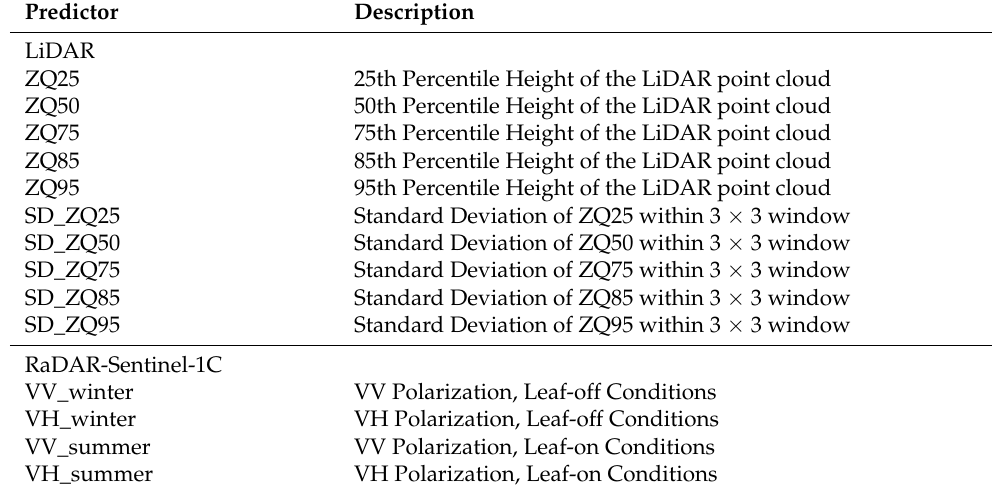
Table 1. Summary of all the remotely sensed predictor variables tested for biomass estimation.